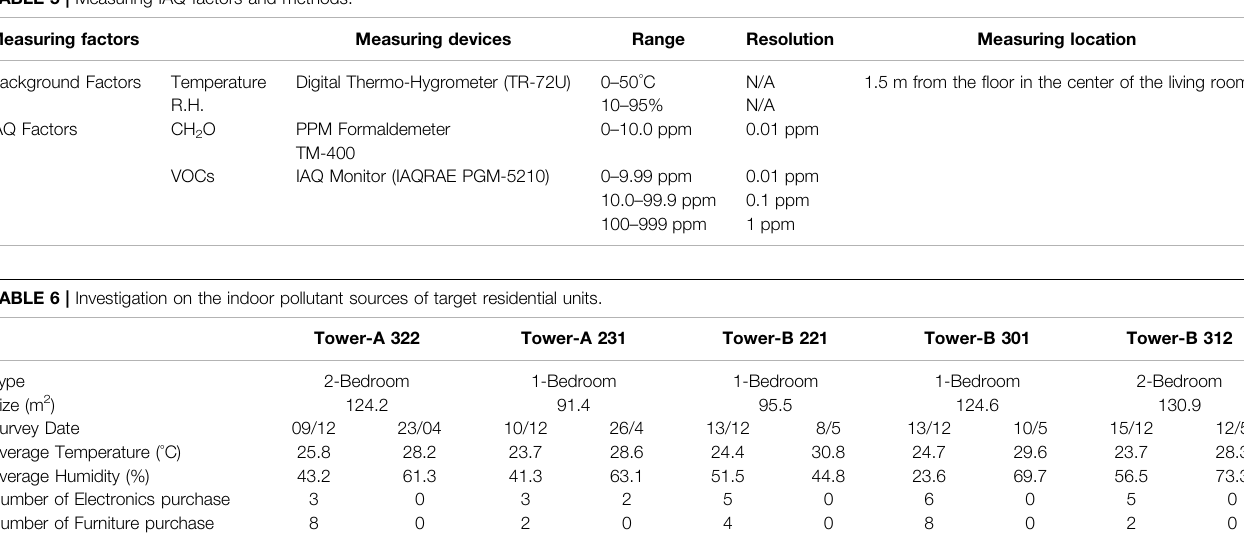
TABLE 5 | Measuring IAQ factors and methods.